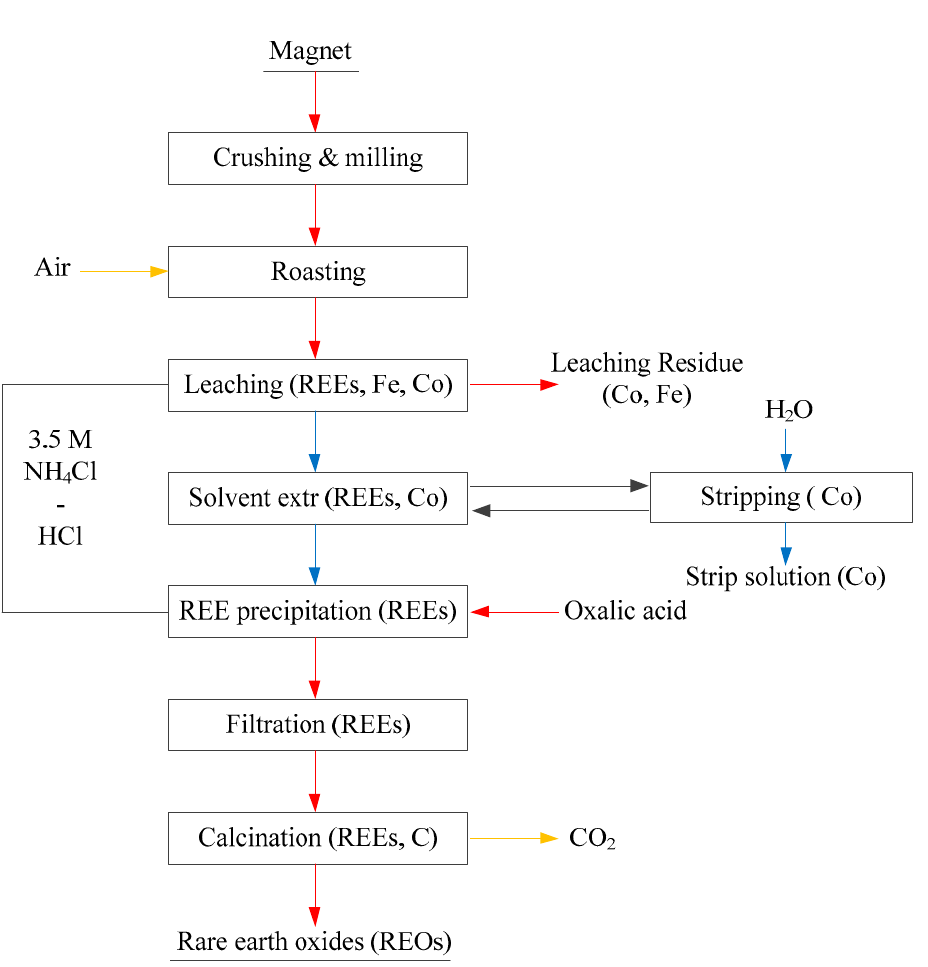
Figure 14. Flow chart of the recycling scheme. Yellow arrows: gas steams, blue arrows: aqueous streams, black arrows: ionic liquid steam, and red arrows: solid streams [56]; published by Royal Society of Chemistry, 2014